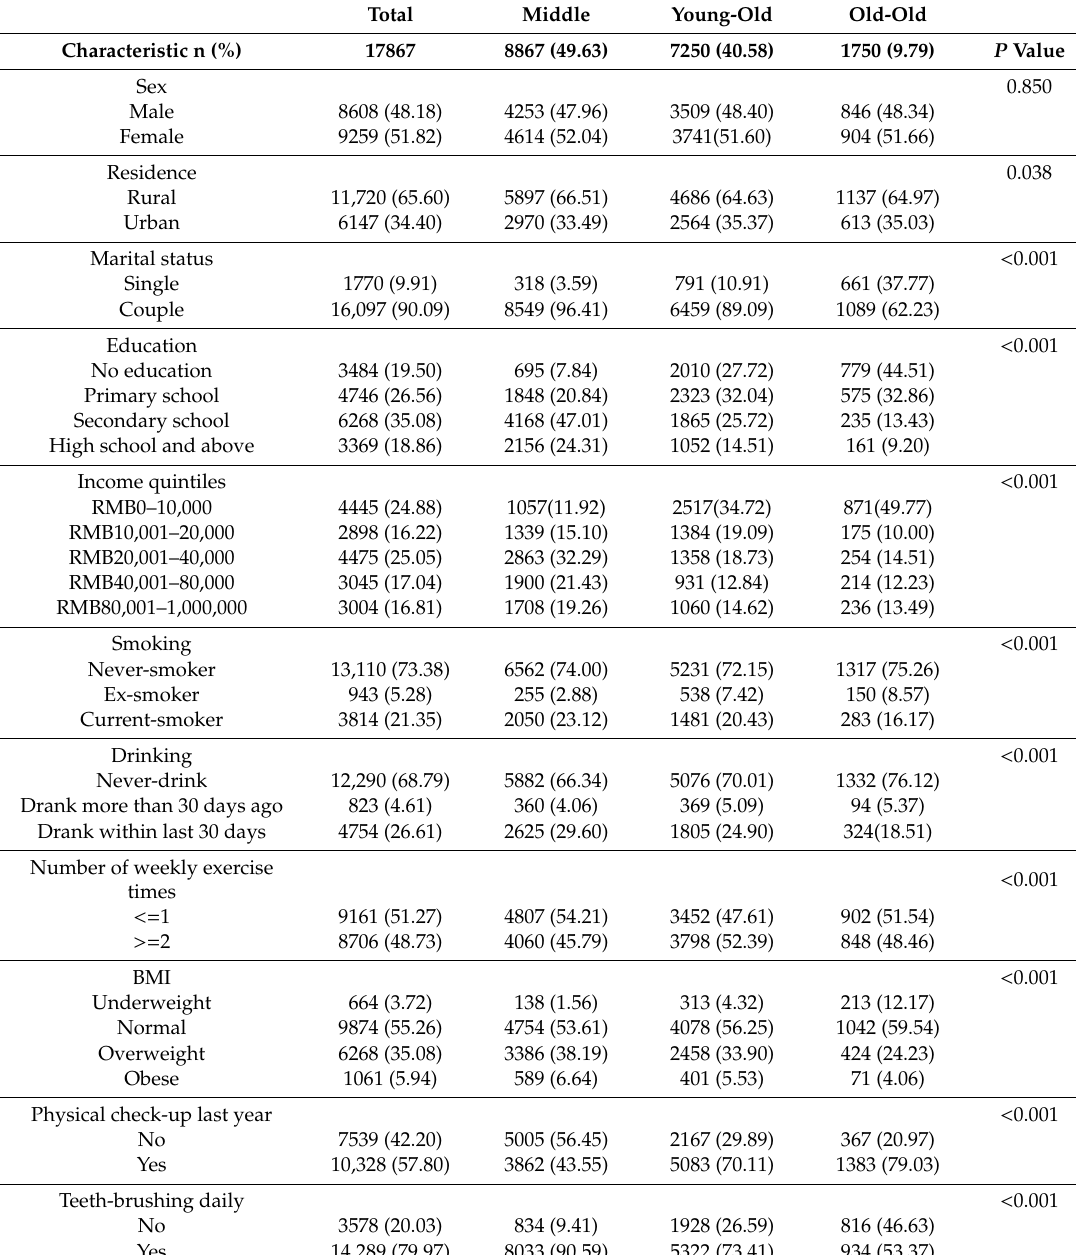
Table 1. Descriptive characteristics of study samples by age groups (n,